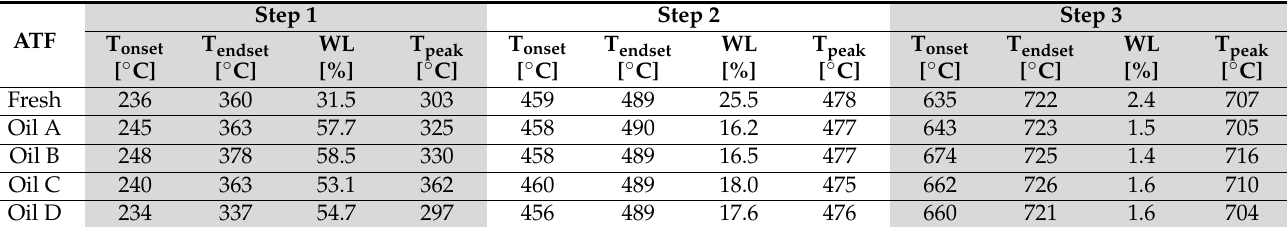
Table 8. TGA and DTGA data for fresh and 168 h aged EPDM.